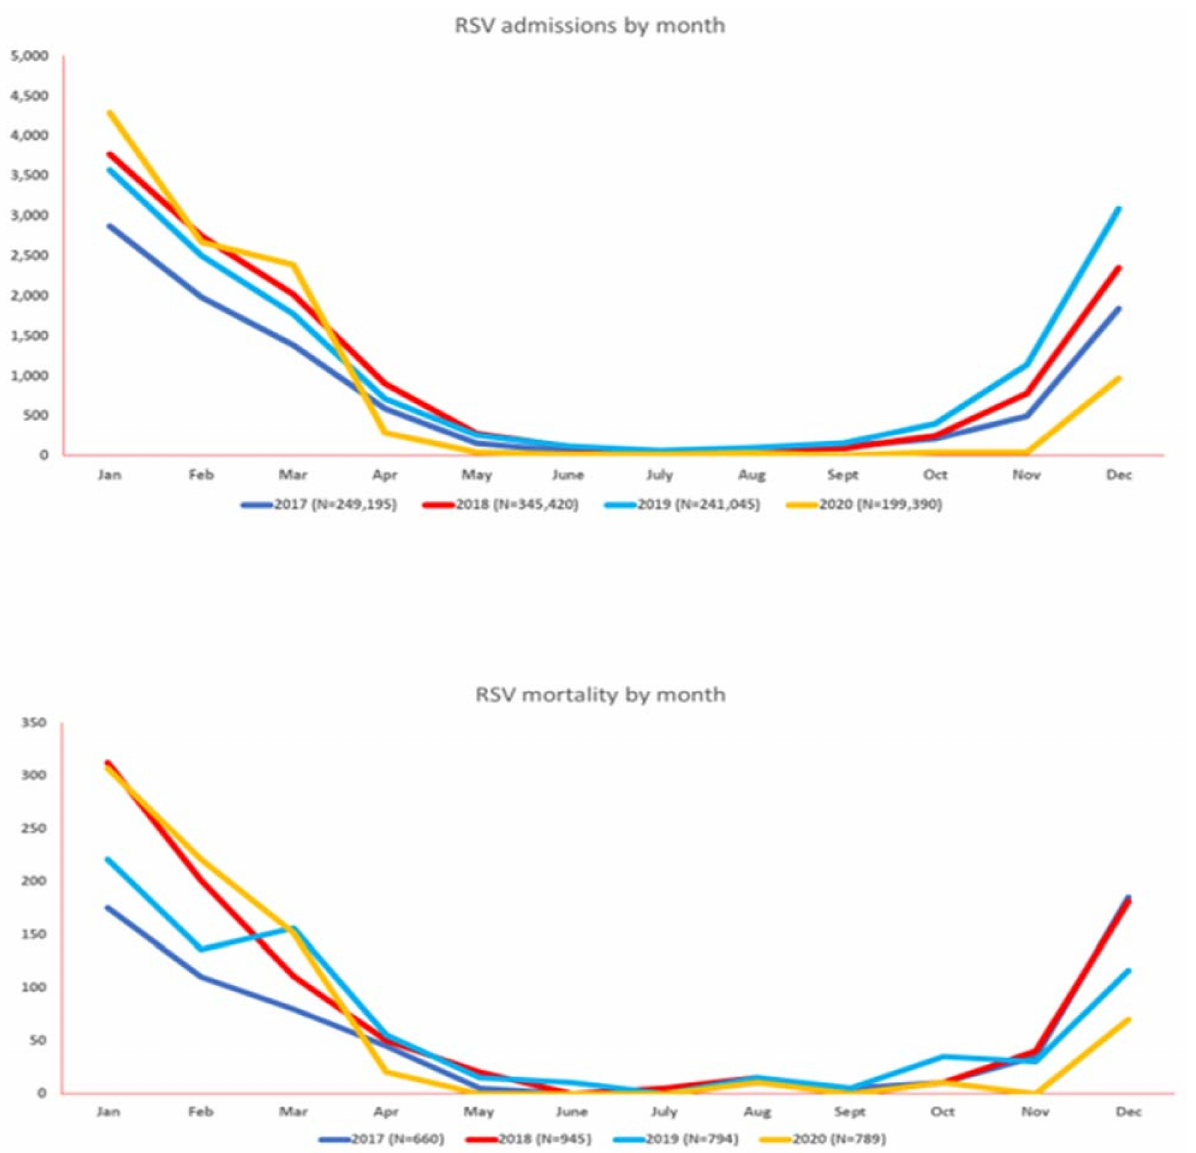
Figure 2. Monthly seasonal variations in the amount of respiratory syncytial virus (RSV) activity (hospitalizations at top, mortality at bottom) from